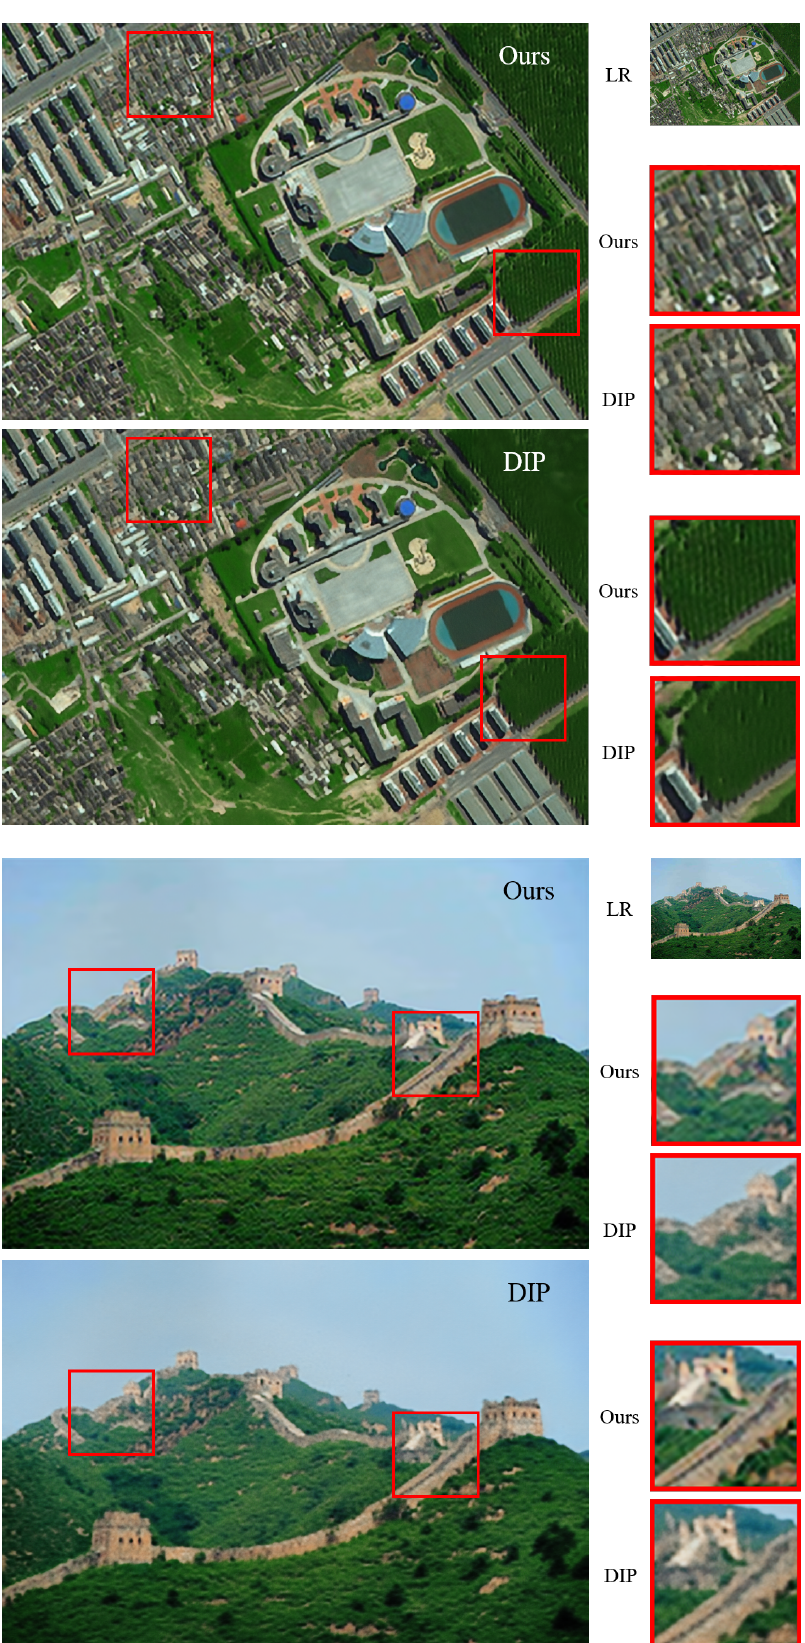
Figure 9. The visualization of 4 × super resolution results of our method and Deep Image Prior (DIP) on two real